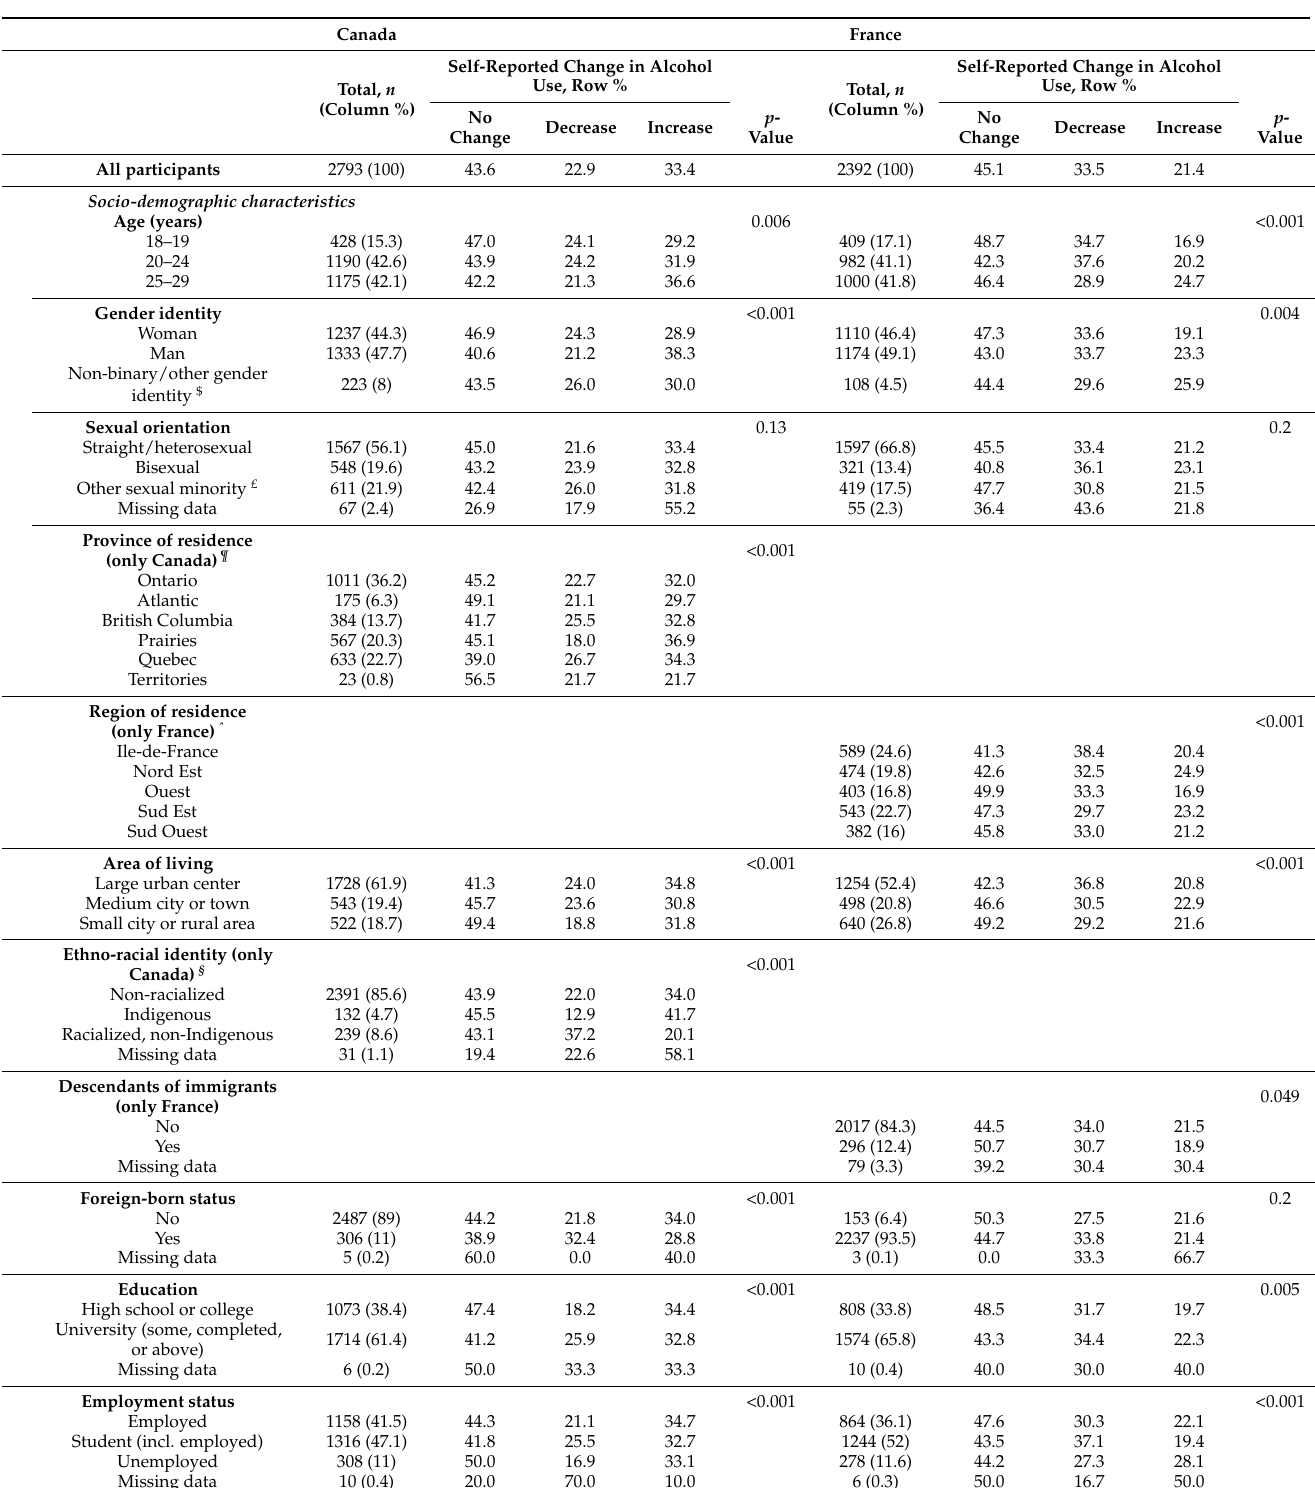
Table 1. Characteristics of the study population after weighting (overall and by groups of changes in alcohol use) in Canada ( n = 2793) and France ( n =